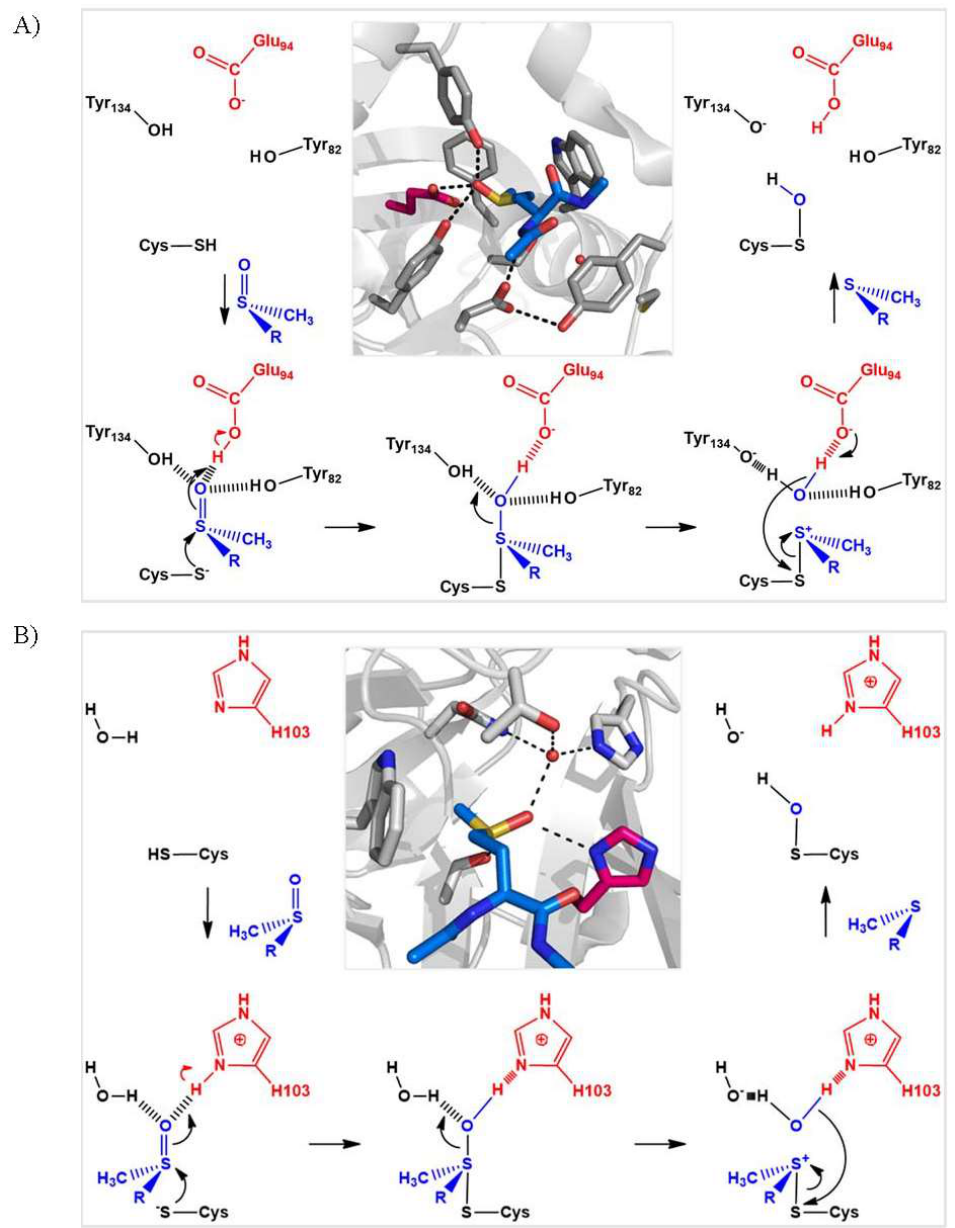
Figure 4. Proposed scenario for formation of the sulfenic acid intermediate in MSRA ( A ) and MSRB ( B ). In the Michaelis complex, the oxygen of the sulfoxide function of Met-O (in blue) is stabilized by hydrogen-bonding interactions. The transfer of a proton from the acid catalyst (in red) leads to the formation of a sulfurane, followed by that of a sulfonium cation and a water molecule via protonation. The activated water molecule then attacks the Cys sulfur of the sulfonium cation to generate the sulfenic acid and Met. For N. meningitidis MSRA and MSRB, the catalytic cysteine, general acid catalyst and proton donor are Cys51, the carboxylate of Glu94 and Tyr82 or Tyr134, and Cys 117, the imidazolium ring of His103 and a water molecule, respectively. The representations of the active sites of C51S MSRA (pdb 3bqf) and C117S MSRB (pdb 3hch) in complex with Ac- L -Met- S -ONHMe and Ac- L -Met- R -ONHMe, respectively, were generated using the PyMol program (DeLano Scientific